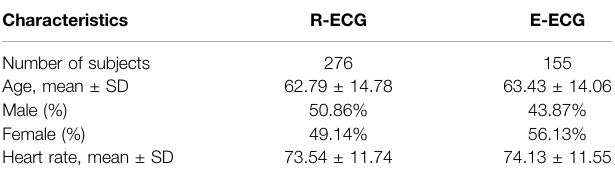
TABLE 1 | Characteristics of R-ECG and E-ECG